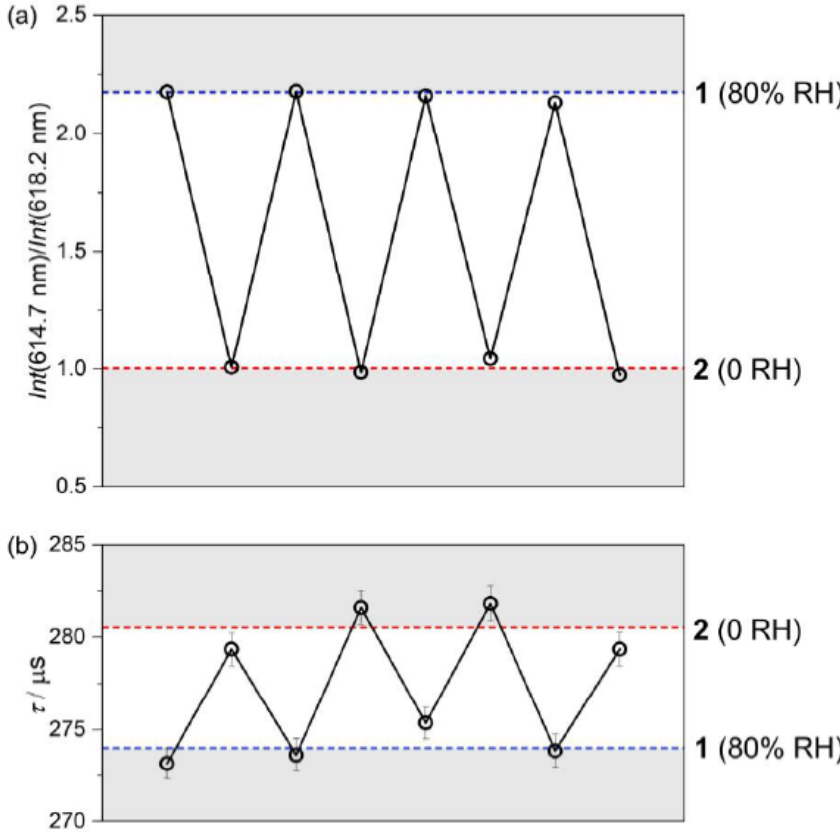
Figure 4. Repeatability of the emission signal in the subsequent dehydration/hydration cycles, performed at room temperature, presented using the intensity ratio between the emission maxima located at 614.7 and 618.2 nm ( a ) and using the values of the extracted emission lifetimes ( b ). The related emission decay profiles were presented in Figure S8 in the Supplementary Materials. Blue and red dashed lines indicate 0 and 80% relative humidity values,